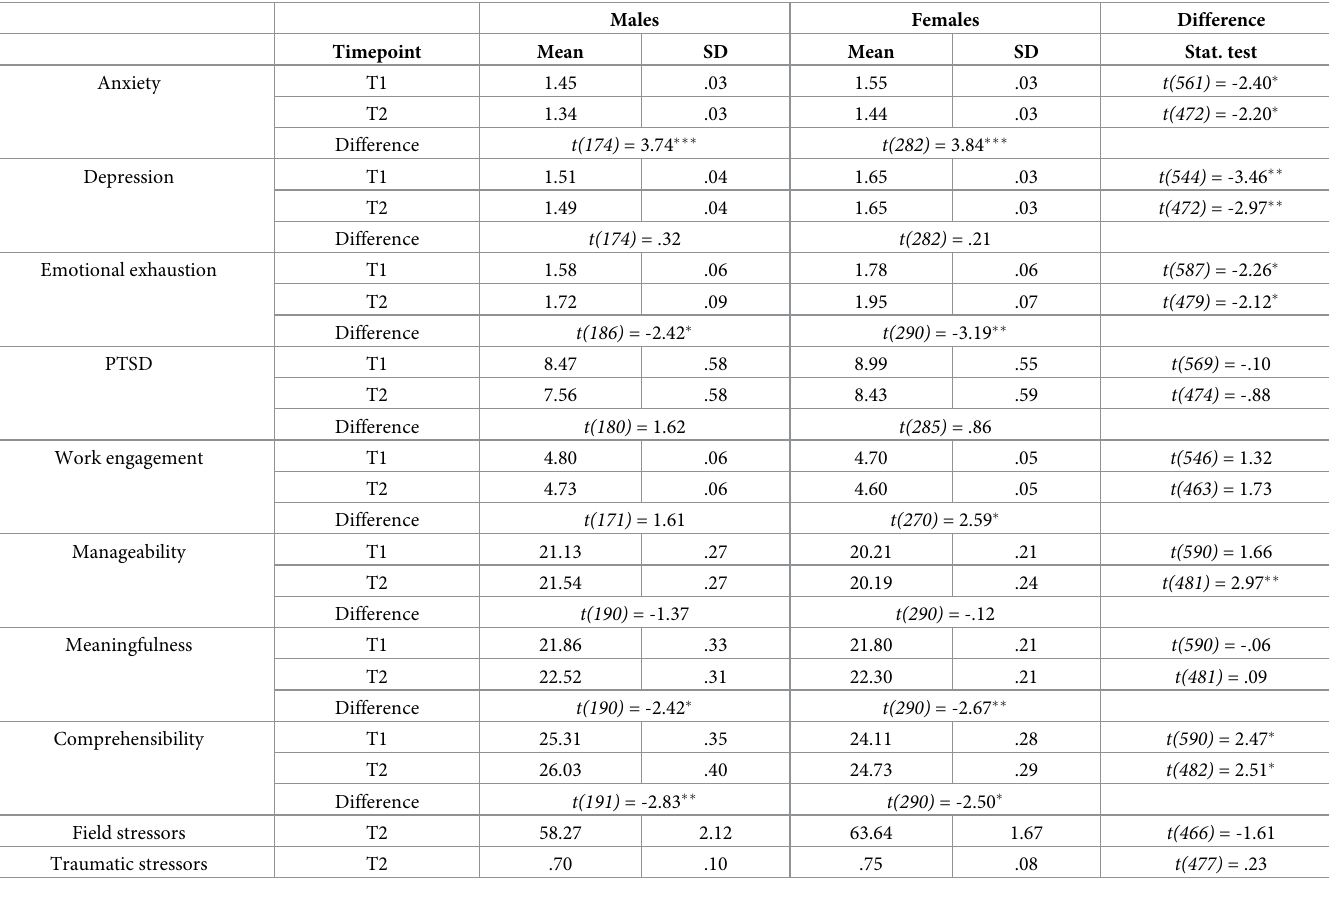
Table 1. Descriptive statistics of the health outcome variables before assignment (T1) and after assignment (T2). Males Females